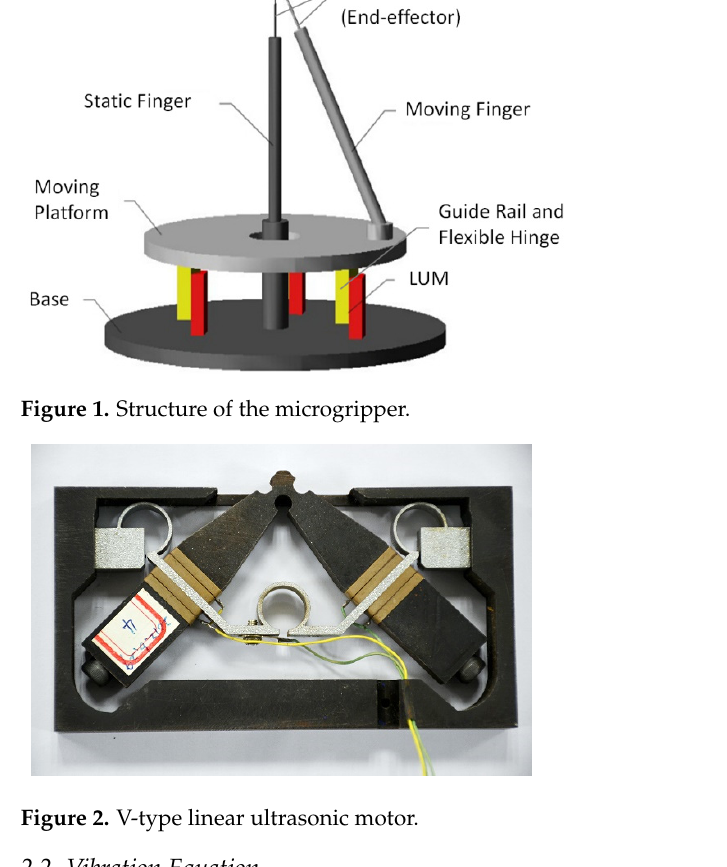
Figure 2. V-type linear ultrasonic motor.